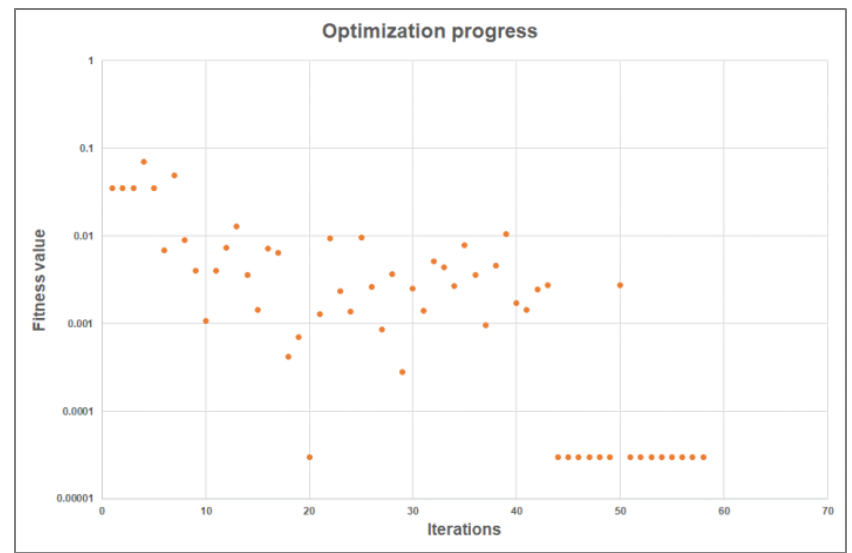
Figure 14. Evolution of the optimization process. Table 4. Nucleation